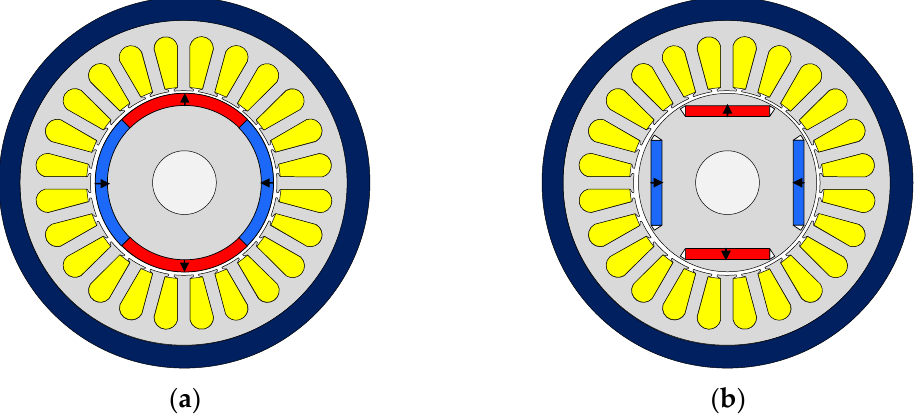
Figure 3. Typical configurations of radial flux PM machines. ( a ) SPM machine. ( b ) IPM machine.